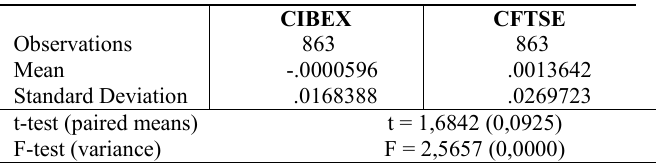
Table 4: Descriptive statistics of CIBEX and CFTSE